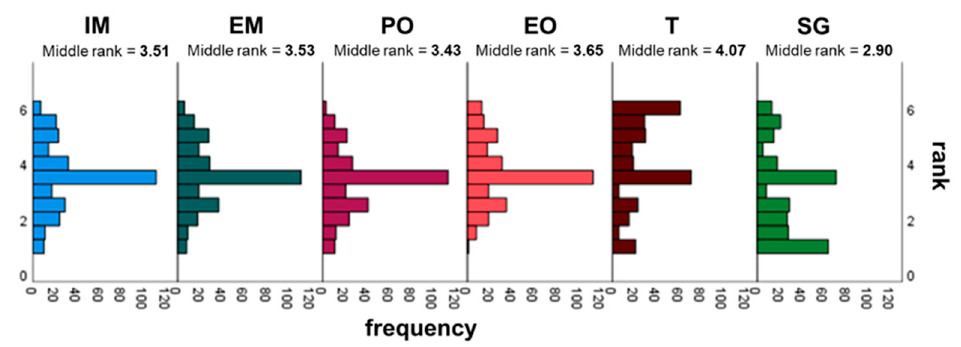
Figure 1. Two-factor variance analysis for ranks, according to Friedman, for the isolated expres- sions.